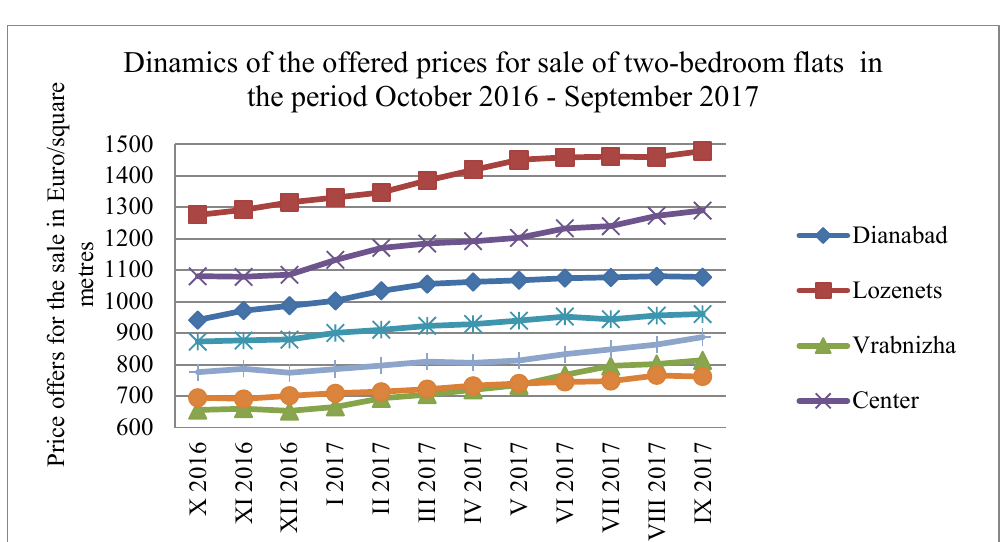
Fig. 3. Dynamics of the offered prices for sale of two-bedroom flats in the period from October 2016 to September 2017 for some neighbourhoods in Sofia (developed by the authors, using www.imot.bg)